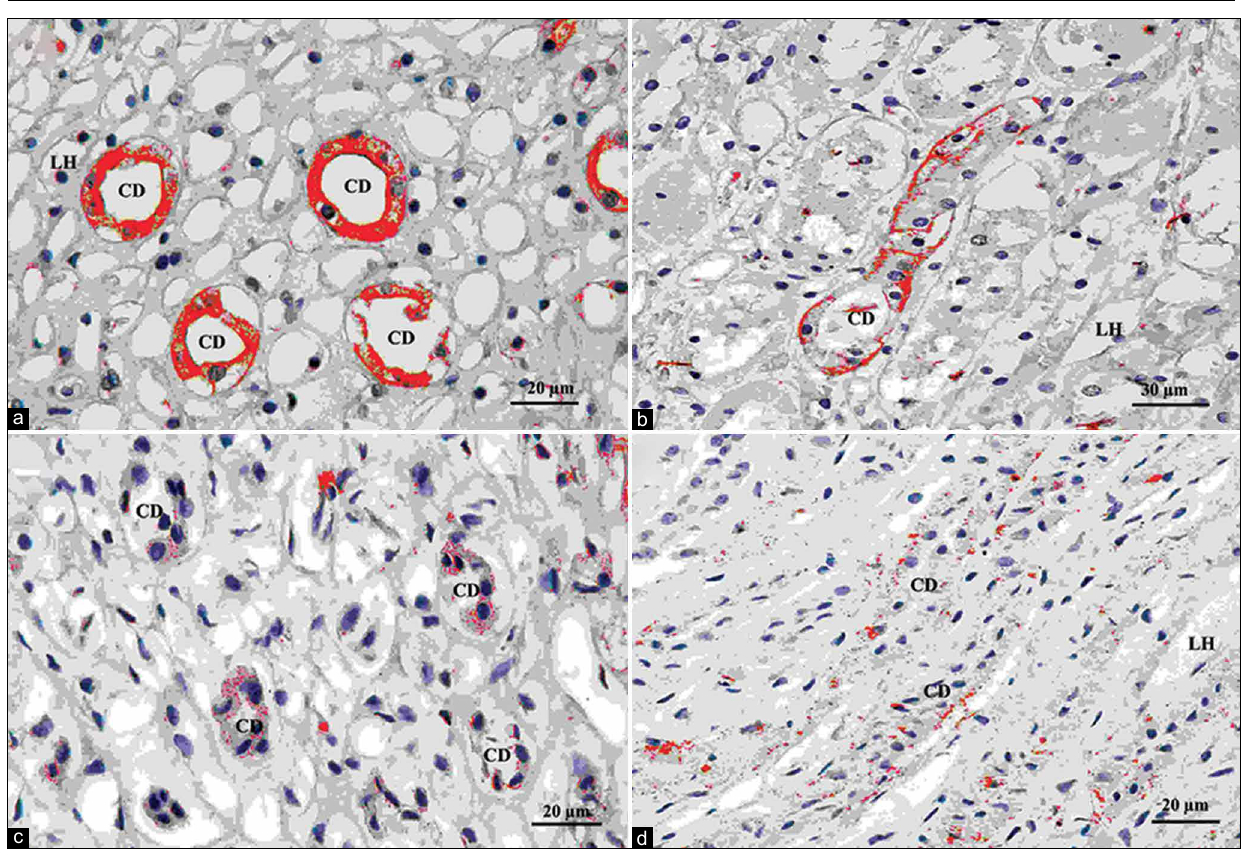
Figure-3: High magnification images were shown of immunolabeling aquaporin (AQP) 2 and arginine vasopressin receptor (AVPR) 2 in normal canine kidney (a and b) and were compared to immunolabeling AQP2 and AVPR2 in chronic kidney disease (CKD) (c and d). The protein localization and expression were shown in red color. The immunolabeling revealed that AQP2 (c) and AVPR2 (d) expressions were lower in canines with CKD when compared to AQP2 (a) and AVPR2 (b) expression in normal kidney. CD=Collecting duct, LH=Thin segment Henle’s